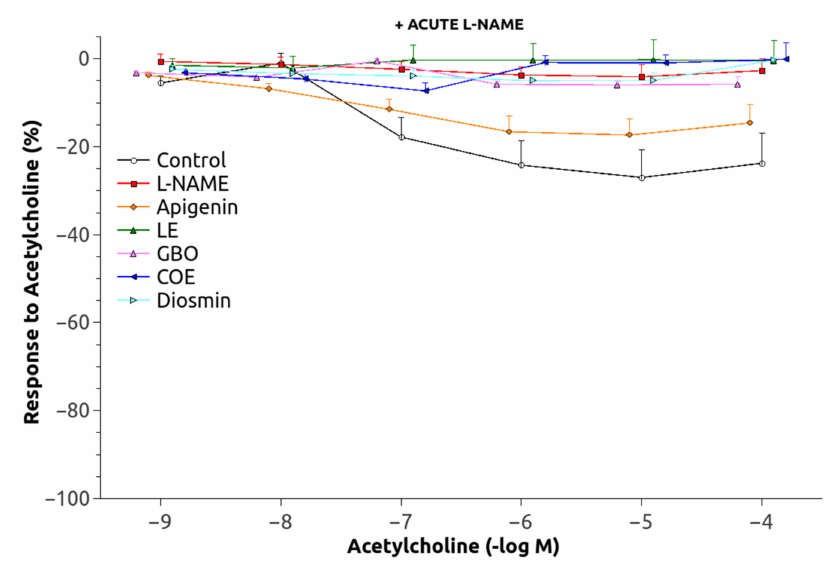
Figure 5. Vasodilatory response to acetylcholine in phenylephrine-preconstricted aortic rings, in the presence of acute L-NAME. Abbreviations as in Figure 1.